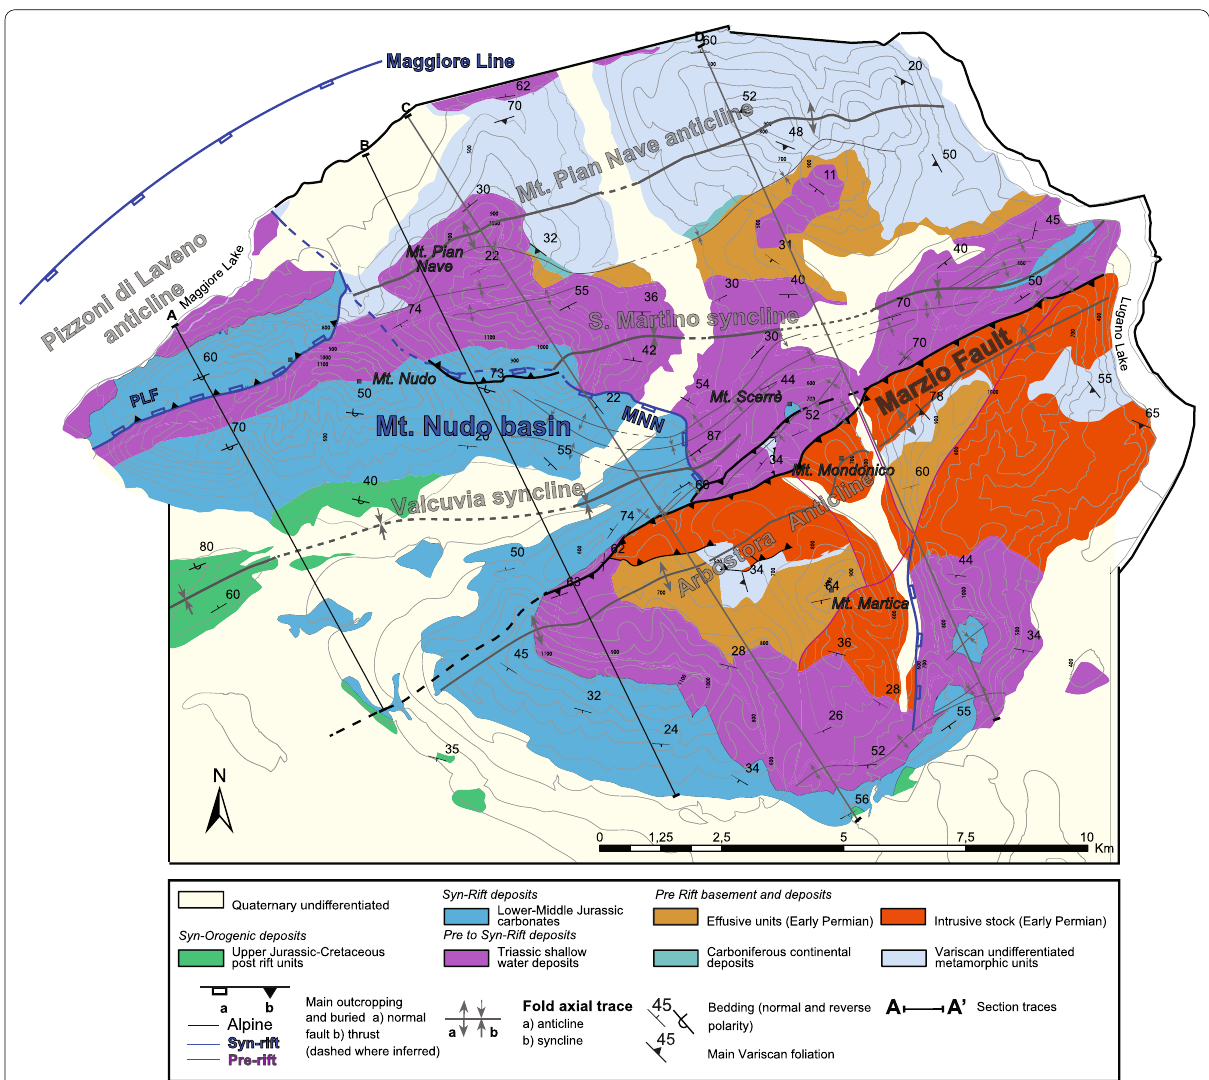
Fig. 2 Simplified geological map of the Varese area based on the geological survey performed for this study (1:25.000